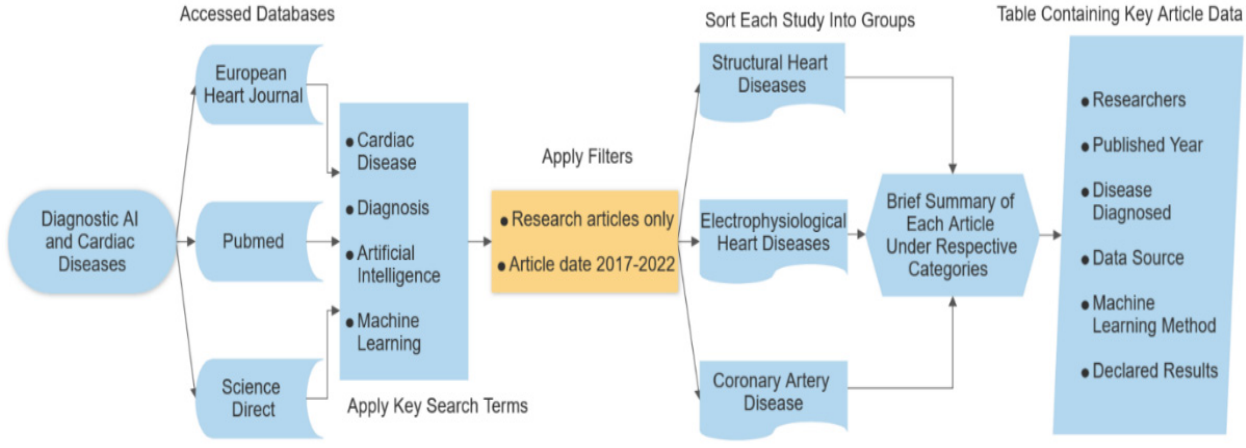
Figure 2. Flowchart of method design for this review.